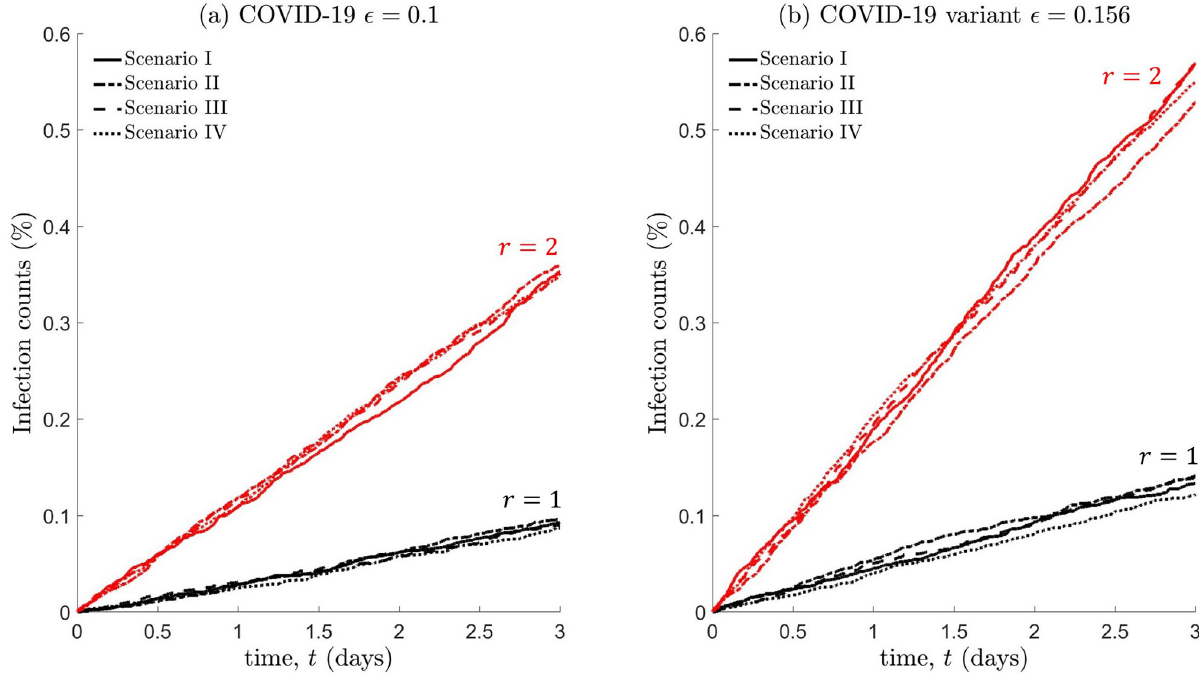
Fig 8. Infection counts for a homogeneously distributed population, under the lockdown scenarios I-IV shown in Fig 4. Each individual in the population performs a SRW. The interaction radius is r = 1m (black) or r = 2m (red), with transmission probabilities (a) � = 0.1 (COVID-19) or (b) � = 0.156